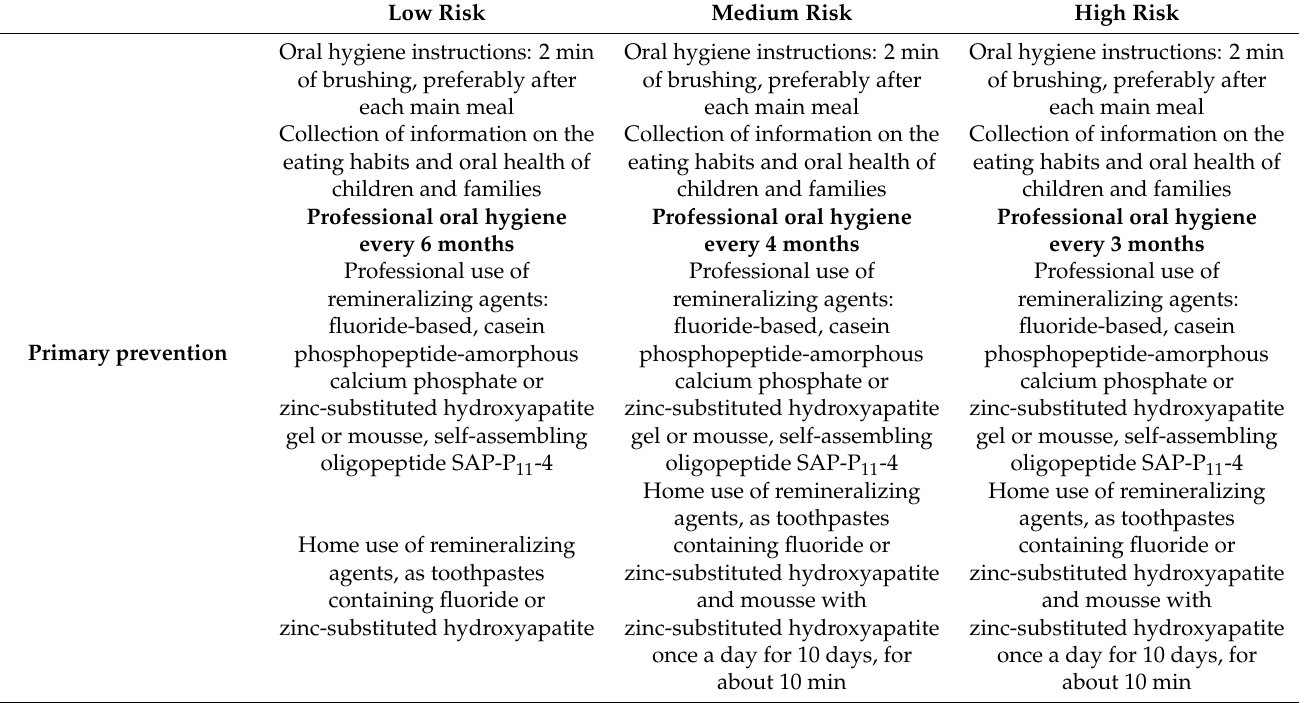
Table 4. Indications for primary prevention in accordance with caries